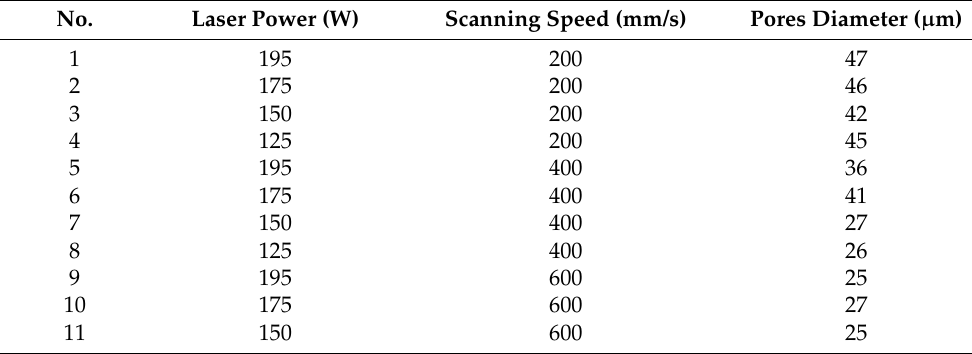
Table 3. Pore diameter for each laser power and scanning speed combination [6].